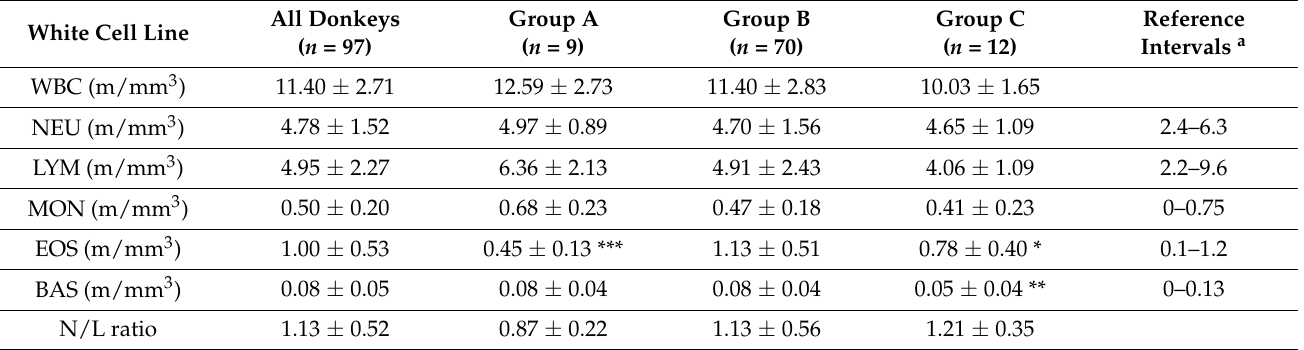
Table 2. Mean ± standard deviation of leucocytes in all donkeys (females and males) and in females in relation to age (A and B) and pregnancy (Group C).